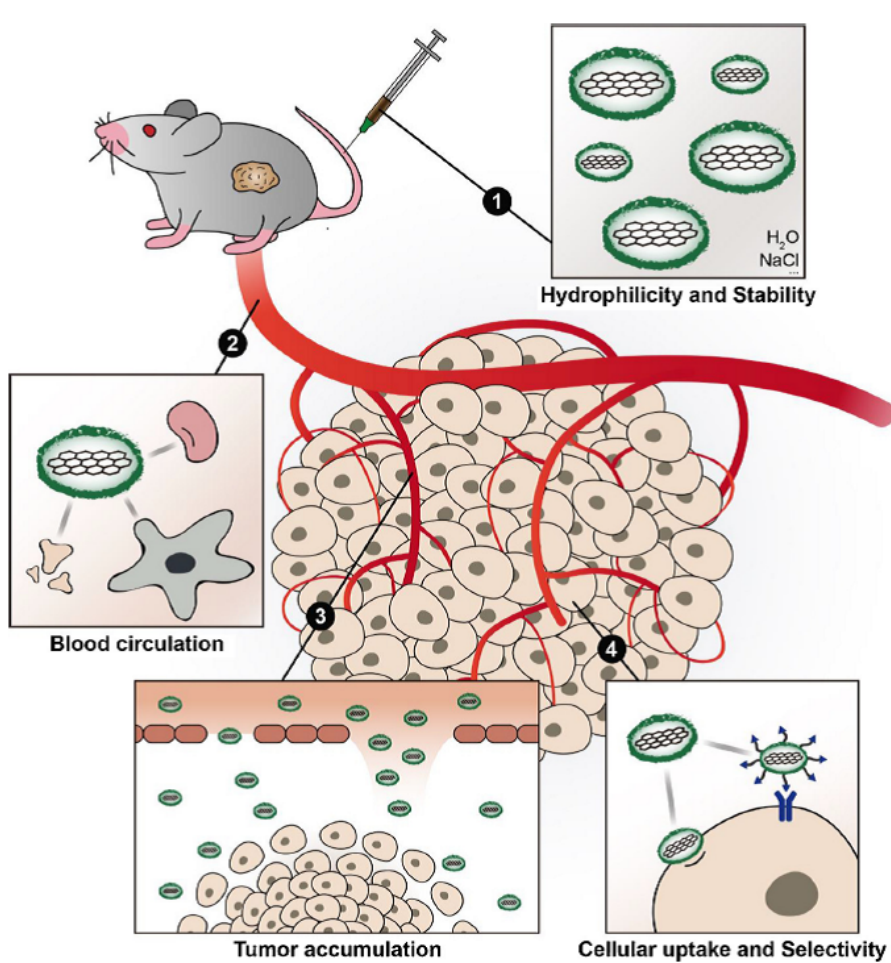
Figure 2. Main directions to improve the functionality of CNMs in biomedicine. Reprinted from [65]. Copyright 2018, with permission from